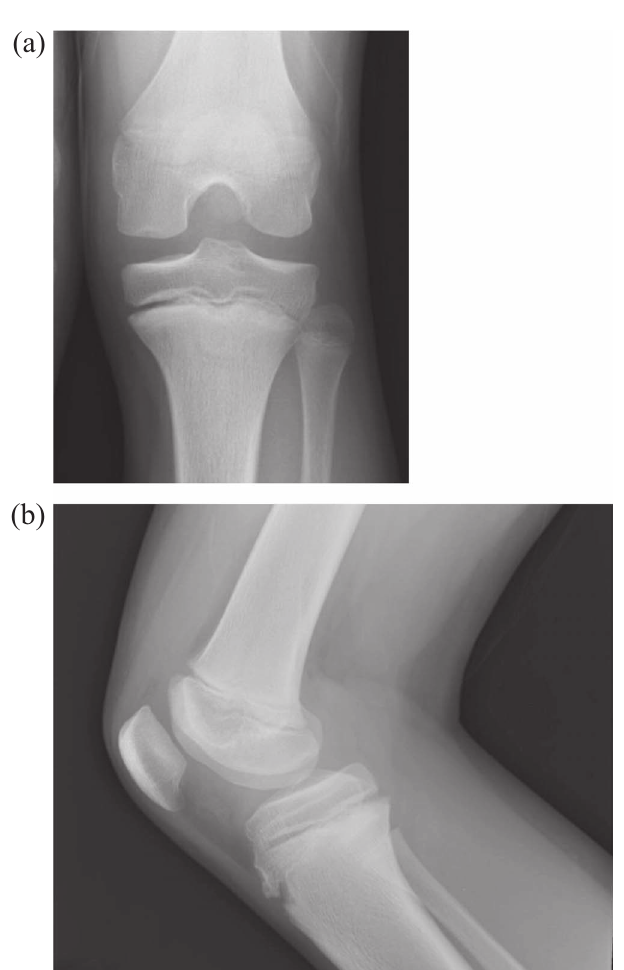
Figure 1. Preoperative AP and lateral radiographs unremarkable for bony pathology (a and b).